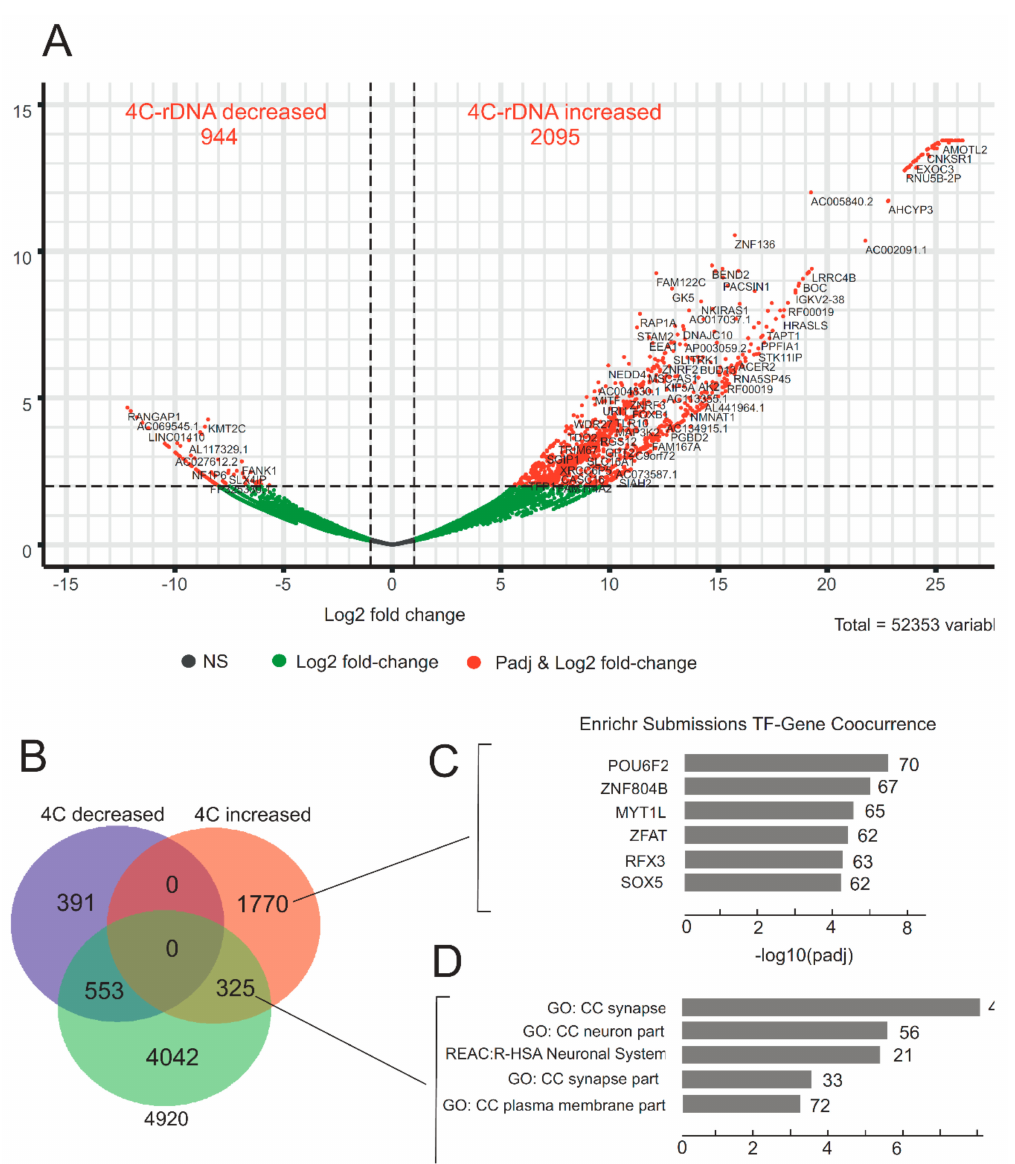
Figure 4. Analysis of changes in the contacts of genes with rDNA clusters after heat shock treatments. ( A ) The volcano plot presents the statistically significant log2-fold changes in contacts of genes with rDNA clusters determined in 4C-rDNA experiments. The list of 52,353 genes from gene annotation for human genome GRCh37 / hg19 build 87 was downloaded from Ensembl FTP server [49]. Of these, 944 genes demonstrated a decrease in the number of contacts, while 2095 genes revealed an increase in the number of contacts. The list of the corresponding genes ranked by padj is shown in Table S9. ( B ) The diagram shows the intersections of these two groups of genes with the list of selected 4920 rDNA-contacting genes detected in non-treated HEK293T cells. The list of the corresponding genes is shown in Table S10. ( C ) The 1770 genes that demonstrated an increase in the number of contacts with rDNA after heat shock treatment were searched using the Enrichr Submissions TF-Gene Co-occurrence library of Enrichr. Genes specifying TFs were identified and demonstrated co-occurrence at specific groups of genes. The top six genes that specify TFs are shown. The value to the right of the bars indicates the number of the regulated genes. The list of these genes is shown in Table S11. ( D ) The top five GO terms associated with rDNA-contacting genes detected in untreated cells that increased their contacts with rDNA after heat shock treatment are associated with the development of neurons. The values to the right of the bars indicate the number of the corresponding genes. The list of these genes is shown in Table